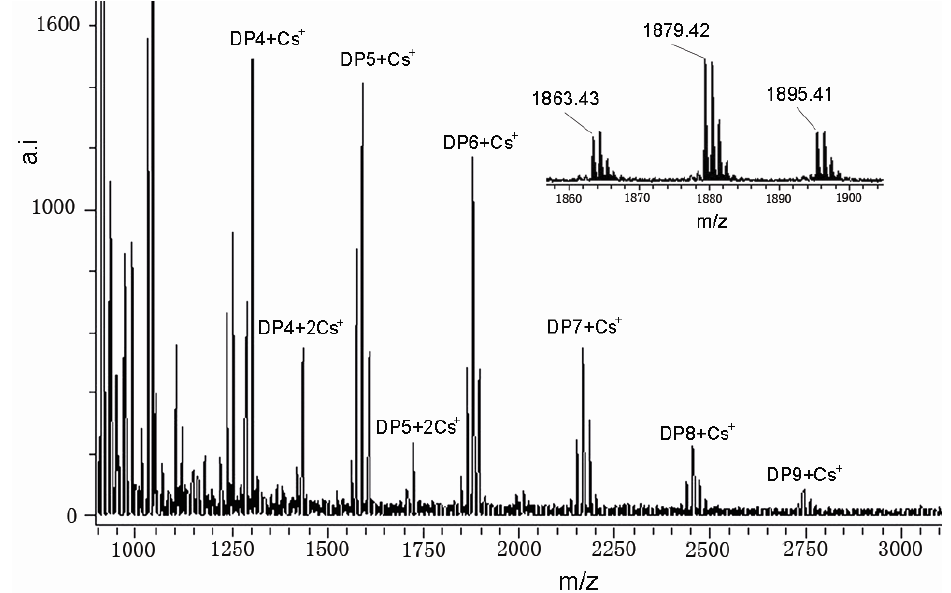
Figure 3. MALDI-TOF positive reflectron mode mass spectra of the condensed tannins from A. mangium . Inset is an enlarged spectrum of masses representing hexamer.